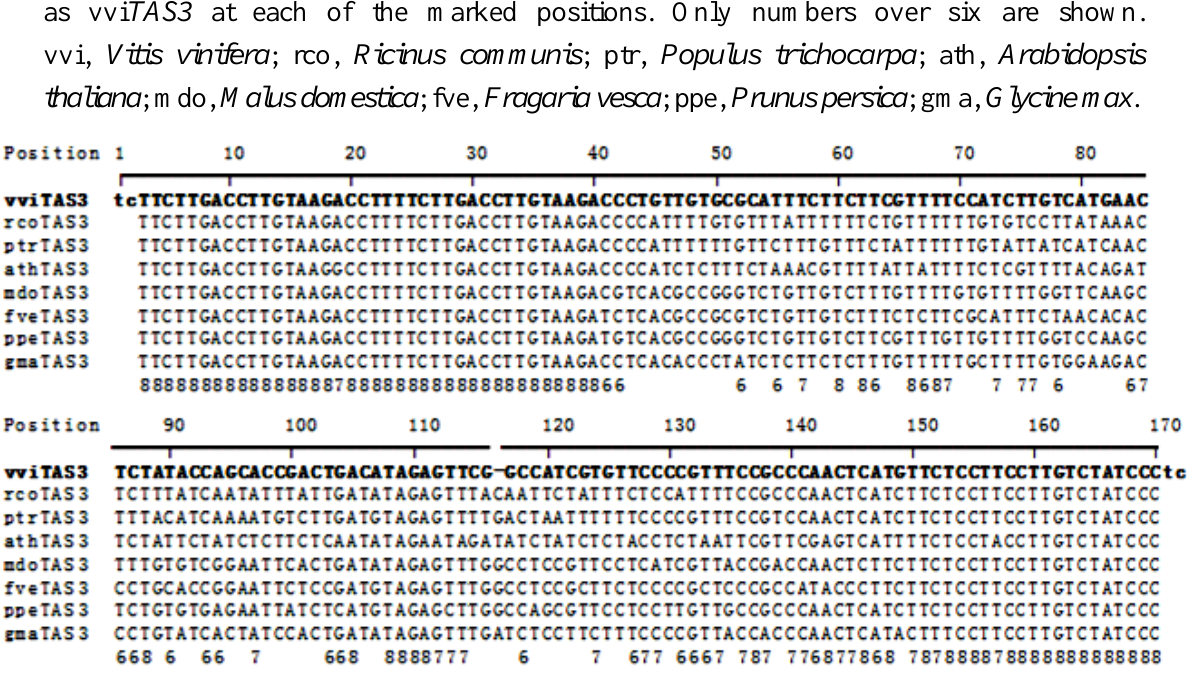
Figure 2. Alignment of TAS3 DNA sequences from eight dicotyledonous plant species. The numbers in the last row indicate the number of species with the same nucleotide as vvi TAS3 at each of the marked positions. Only numbers over six are